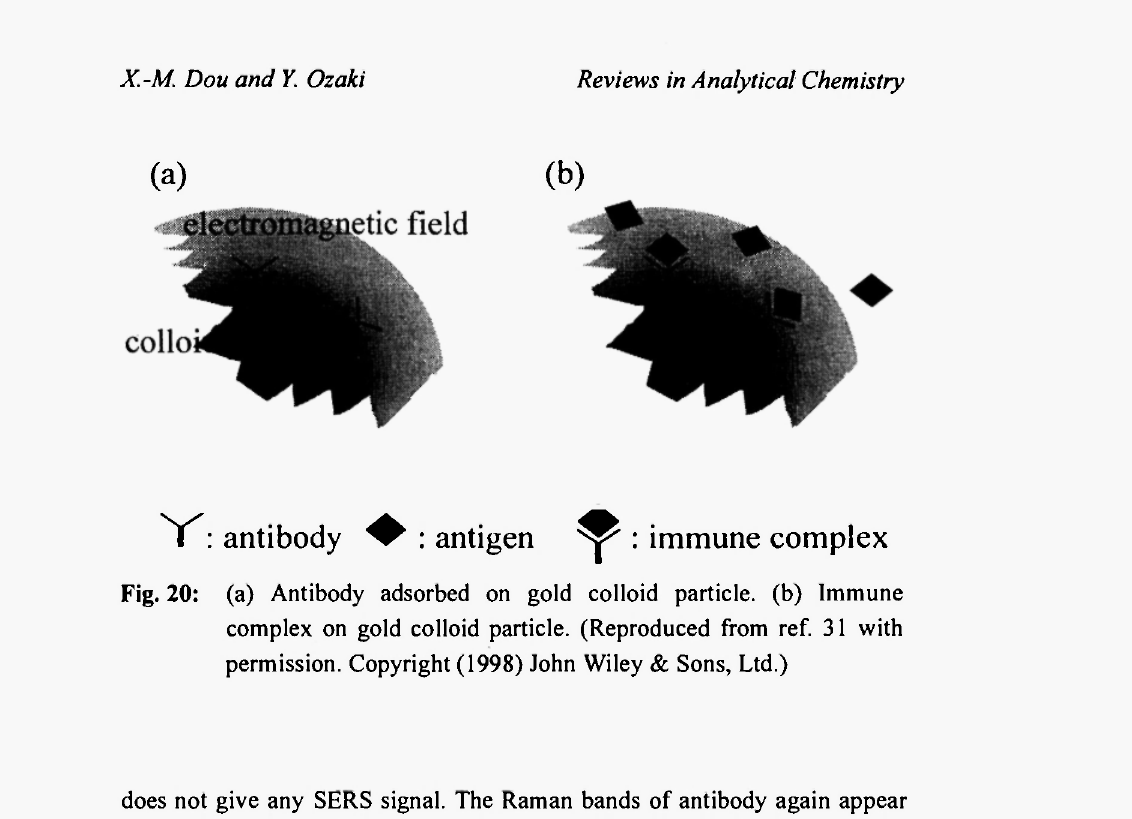
Fig. 20: (a) Antibody adsorbed on gold colloid particle, (b) Immune complex on gold colloid particle. (Reproduced from ref. 31 with permission. Copyright (1998) John Wiley & Sons,